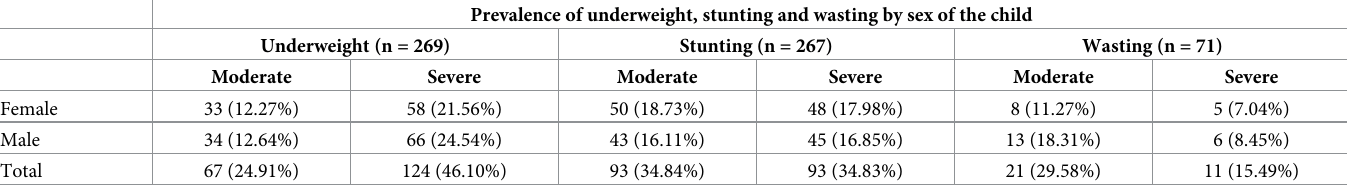
Table 2. Prevalence of underweight, stunting and wasting by sex of the child.